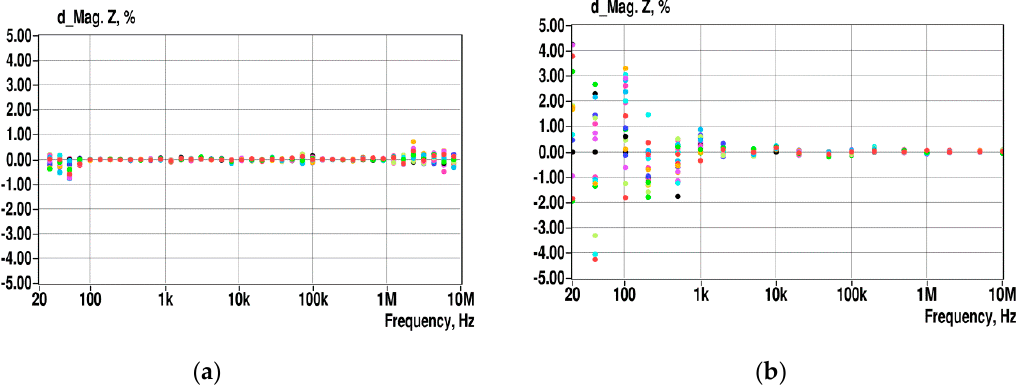
Figure A6. Impedance magnitude variations of the SUT1 measured with the Wayne Kerr analyzer ( a ), and the developed analyzer ( b ).